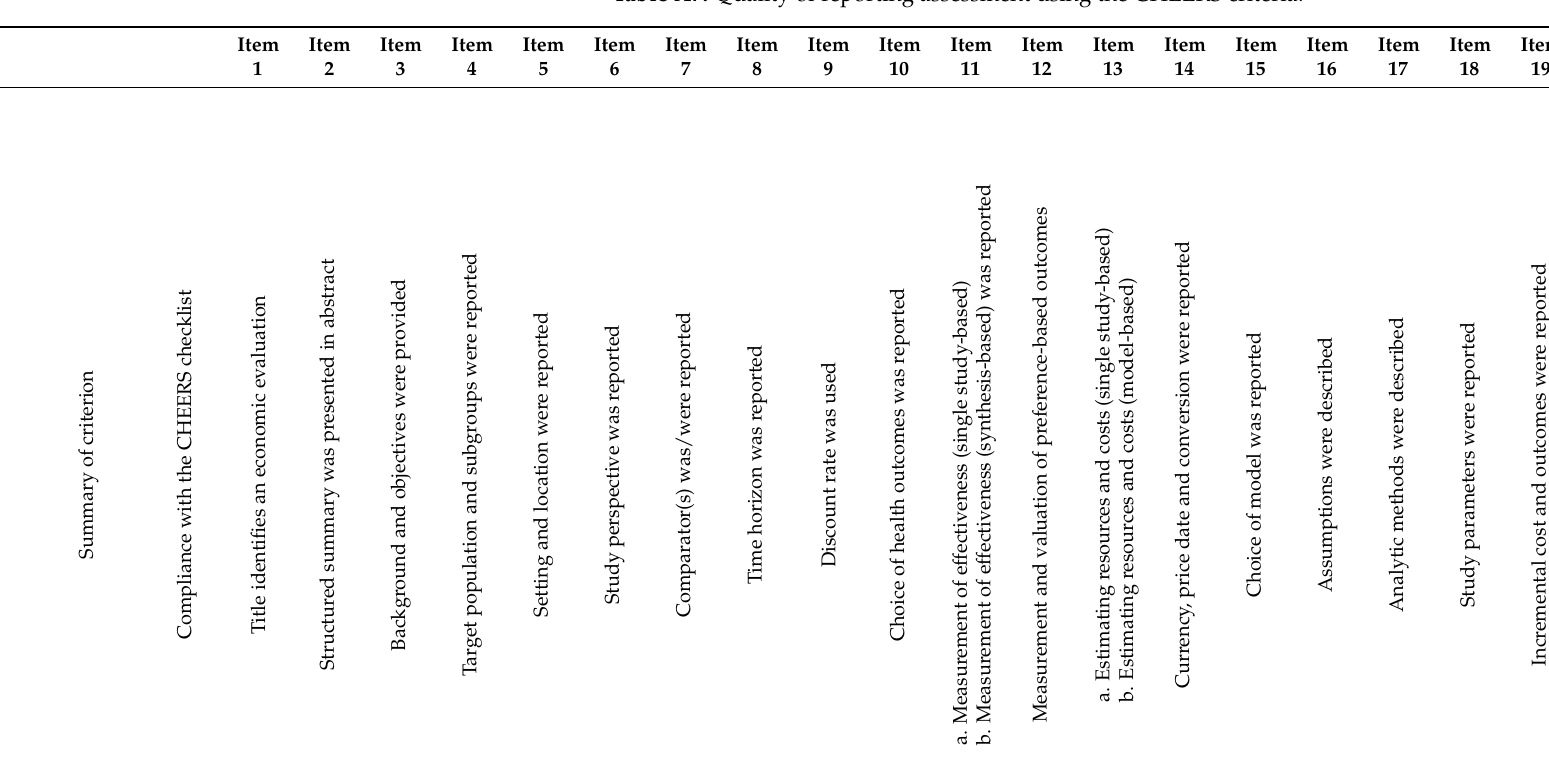
Table A7. Quality of reporting assessment using the CHEERS